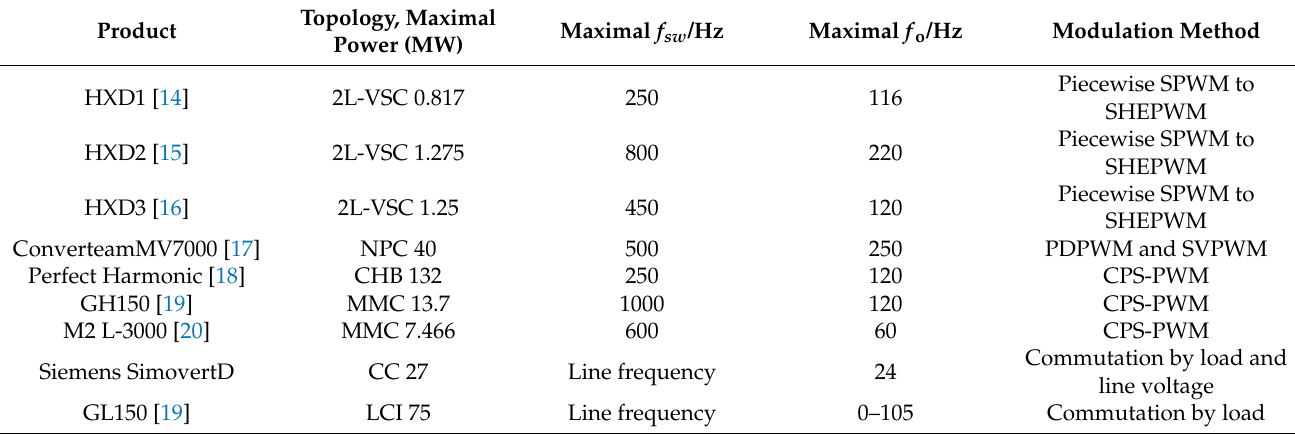
Table 1. Switching frequency and modulation method for industrial high power converters.